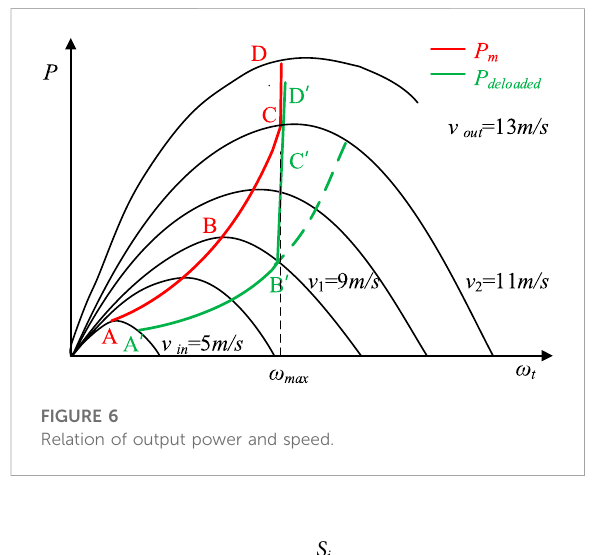
FIGURE 6 Relation of output power and